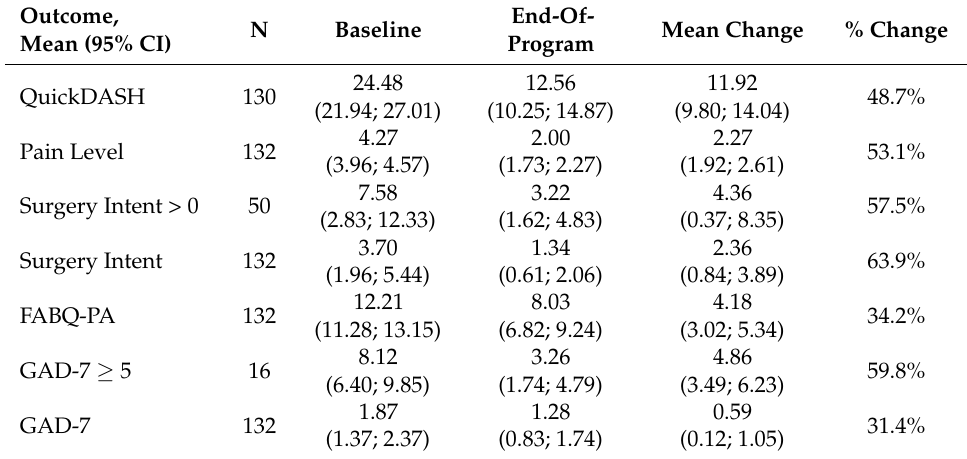
Table 2. Outcome changes between baseline and 8-weeks: intent-to-treat approach (unconditional Table 1. Baseline characteristics of study participants (N = 132).